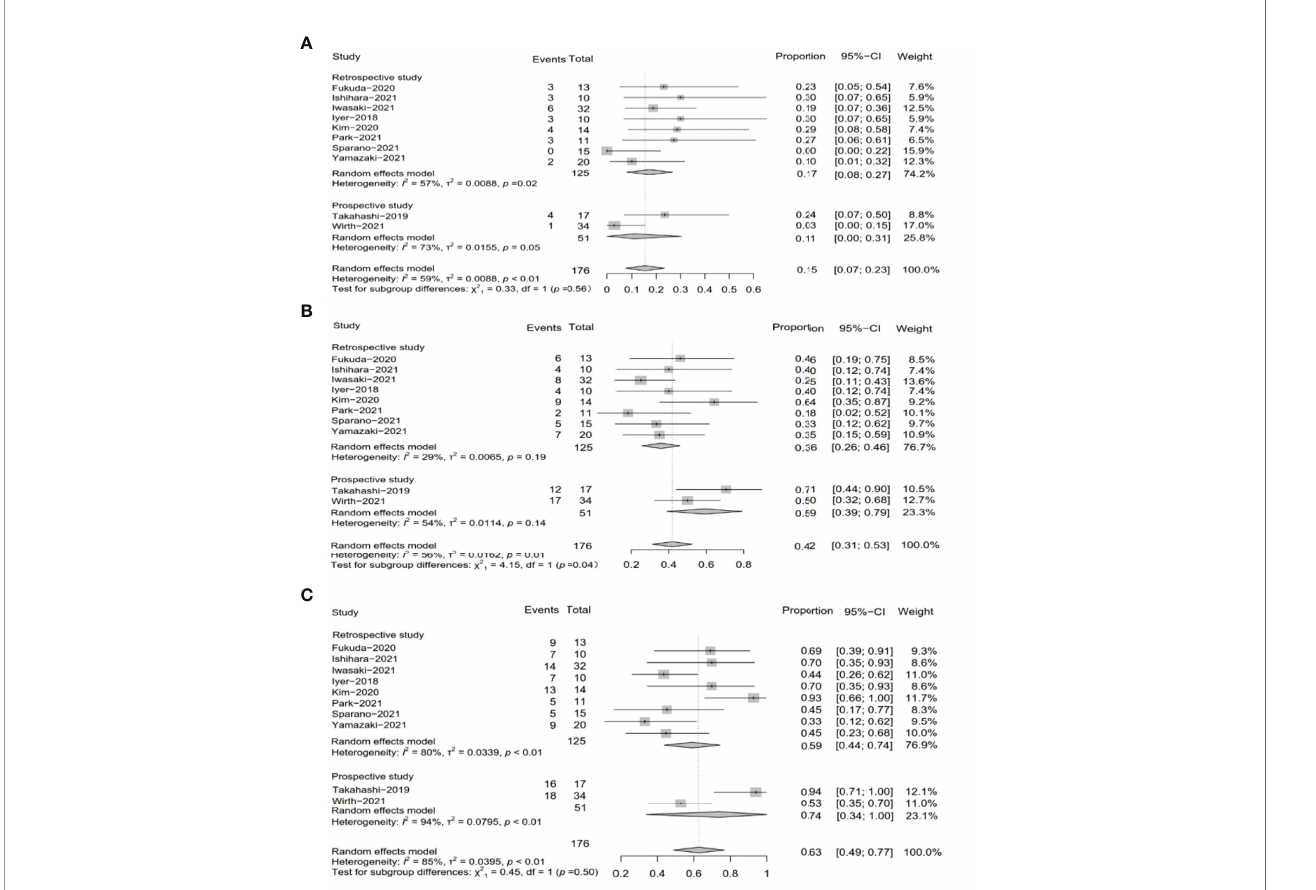
FIGURE 2 | Pooled results of tumor response by study type subgroup. (A) Pooled results of PR in total by research type subgroup. (B) Pooled results of SD in total by research type subgroup. (C) Pooled results of DCR in total by research type